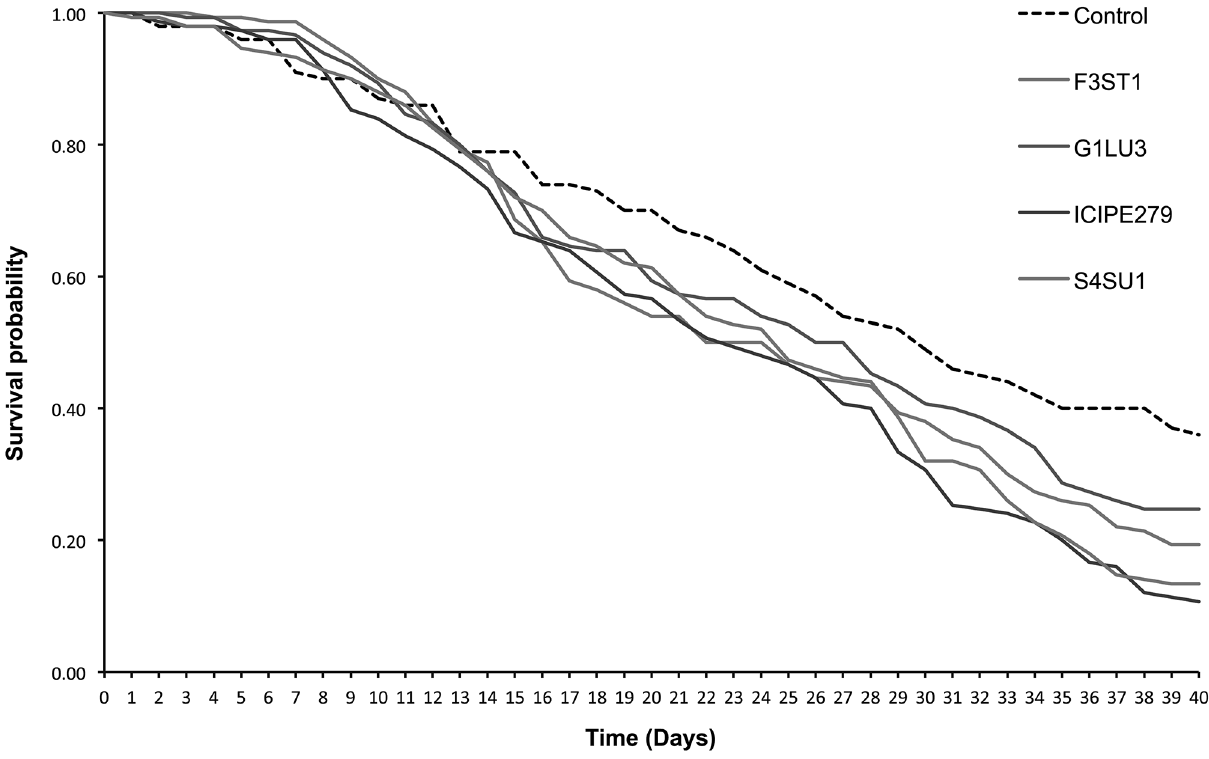
Figure 1. Survival curves for Diglyphusisaea adults parasitizing 2 nd and 3 rd instar Liriomyzahuidobrensis larvae following exposure to Viciafaba plants endophytically-colonized by different fungal isolates of Beauveriabassiana (S4SU1, G1LU3 and ICIPE 279) and Hypocrealixii F3ST1 after 40 days post-exposure.